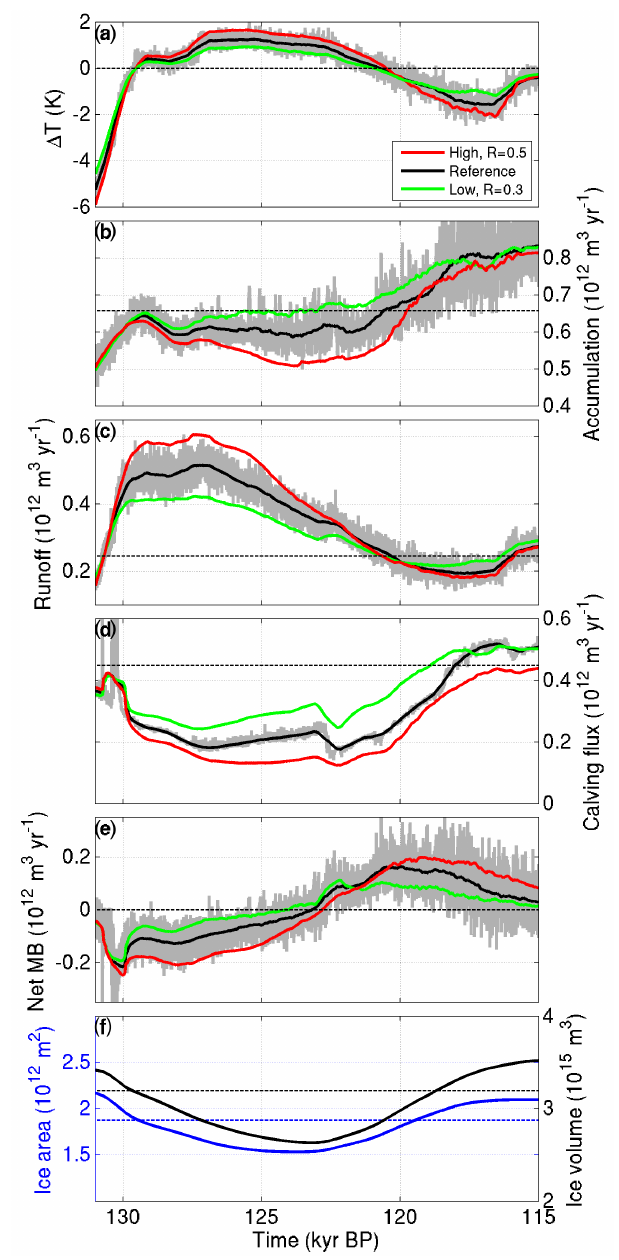
Figure 4. Greenland ice sheet forcing characteristics for the ref- erence run (black) and with higher (red) and lower (green) tem- perature scaling. Climatic temperature anomaly relative to pre- industrial (a) . Accumulation (b) and surface meltwater runoff (c) over grounded ice. Calving flux (d) , net mass balance (e) , and other mass balance terms ( b , c ) given in water equivalent. Ice area (blue) and ice volume (black) for the reference run (f) . All lines are smoothed with a 400-year running mean except for the grey lines giving the full annual time resolution for the reference run. Hori- zontal dashed lines give the pre-industrial reference values, except for panel e , where it is the zero